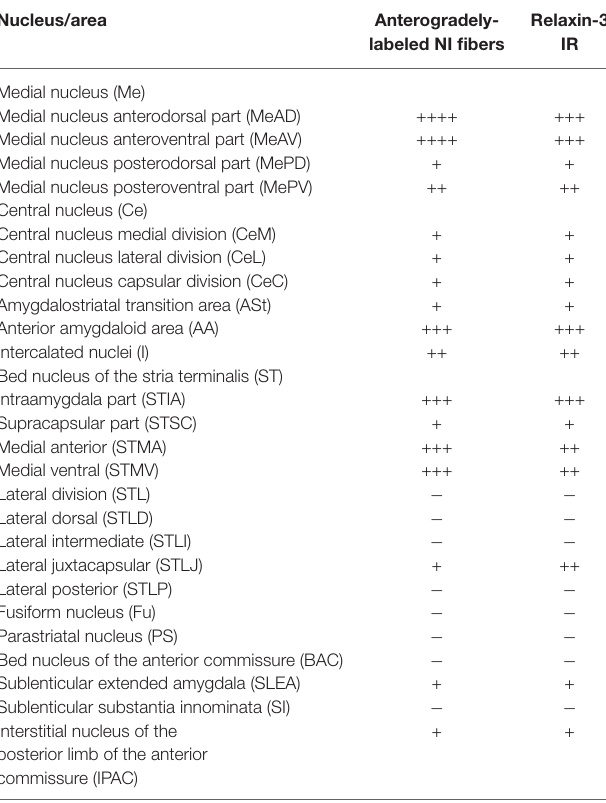
TABLE 2 | Distribution of anterogradely-labeled NI fibers and relaxin-3 positive fibers in subpallial nuclei of amygdala .